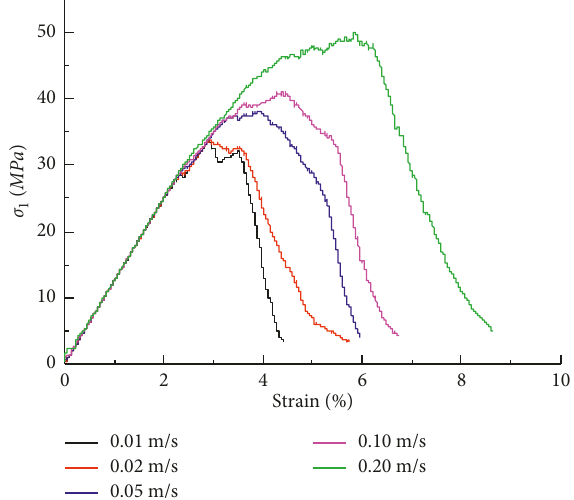
Figure 3: The stress-strain curves of coal-rock combined samples under different loading